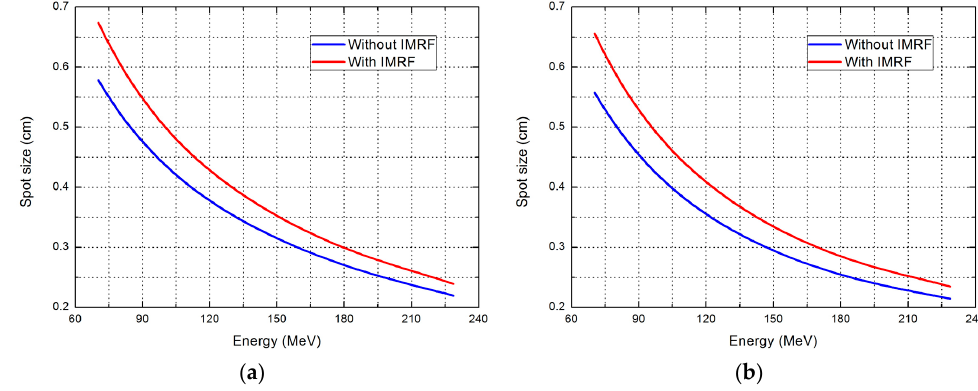
Figure 2. Spot size (1 σ ) for plans with and without IMRF as a function of energy. ( a ) spot size in cross-line direction; ( b ) spot size in in-line direction.